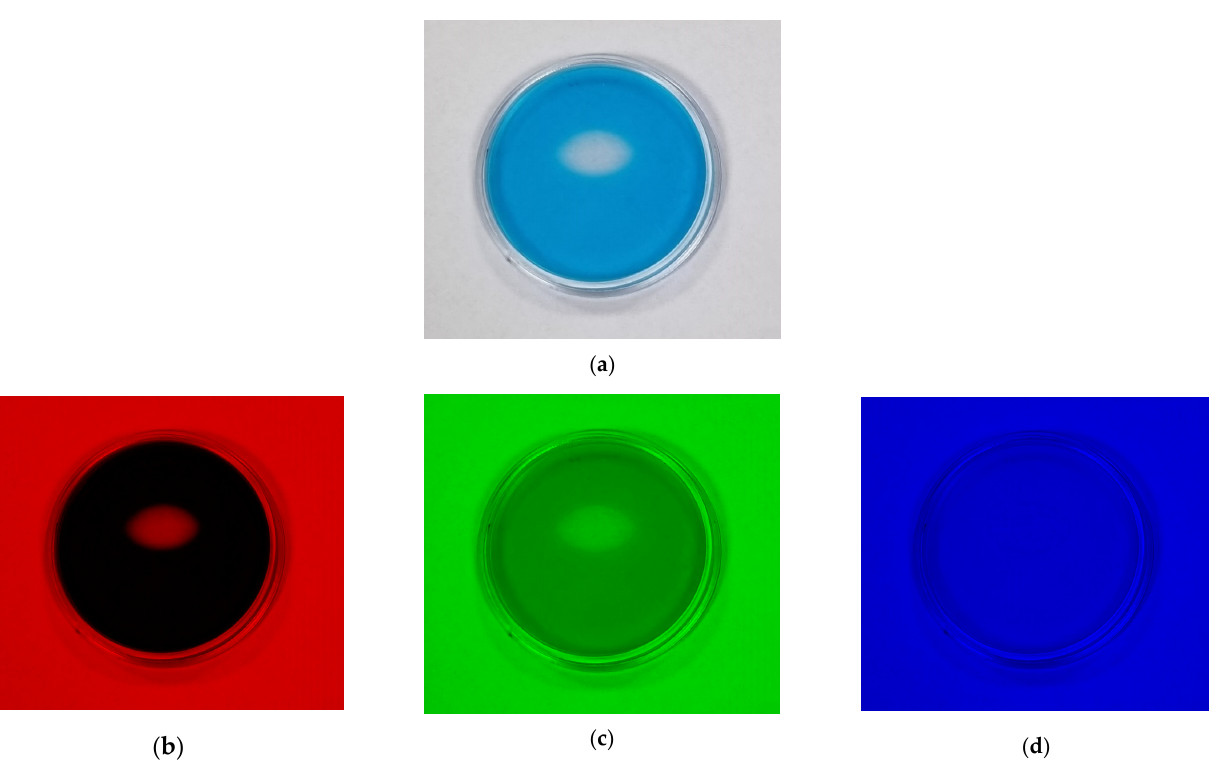
Figure 9. The TBO ‒ Pluronic F ‒ 127 gel sample irradiated in the designated ellipse ‐ shaped part ( a ) Figure 9. The TBO–Pluronic F–127 gel sample irradiated in the designated ellipse-shaped part ( a ) and decomposed into RGB channels: red ( b ), green ( c ) and blue ( d ). and decomposed into RGB channels: red ( b ), green ( c ) and blue ( d The profiles across and along the sample were plotted, as shown in Figure 10c,d. The increase in intensity for the raw sample (grey channel) corresponds to the irradiated part of the sample, which became discoloured. The greatest increase in colour intensity was observed for the red channel, which best illustrates the changes occurring in the sample after irradiation. The changes are not visible for the blue channel due to the analogous colour of the sample. The obtained results clearly indicate the possibility of using TBO ‒ Pluronic F ‒ 127 to record the 2D dose distribution. It is also possible to extend the recording to 3D dose distribution measurements using a 3D optical scanning technique, which is planned for subsequent studies. ( a )